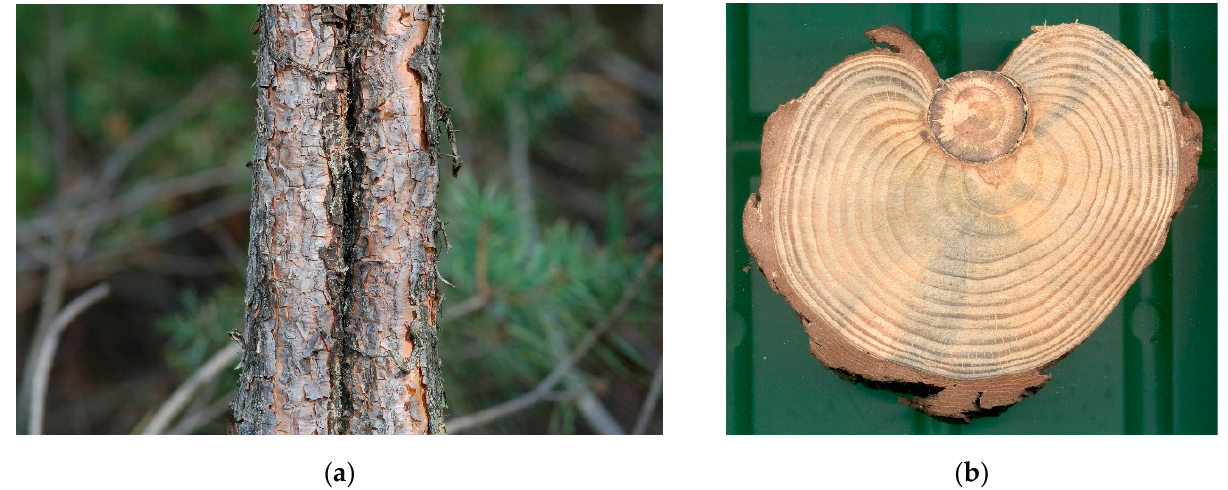
Figure 6. Bark stripping wound on stem of p . sylvestris. ( a ) 30-year-old bark stripping wound, ( b ) cross-section of an old bark stripping wound that showed stem deformation.